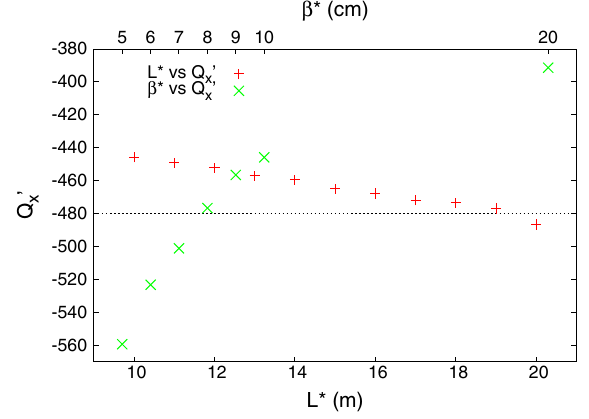
FIG. 12. Limit of the chromatic correction (black dashed line) overlaid in the plot Q 0 x vs L (cid:1) (red) and Q 0 x vs β (cid:1) (green). This limit was found around Q 0 x ≈ − 480 for a maximum of L (cid:1) ¼ 18 m with β (cid:1) ¼ 10 cm and a minimum β (cid:1) of 8 cm with L (cid:1) ¼ 10 m.